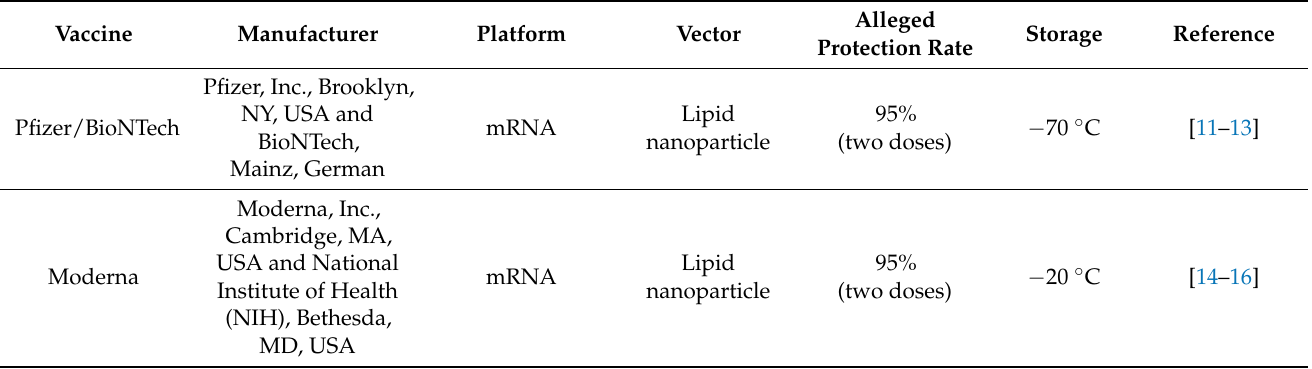
Table 1. Main COVID-19 vaccines approved by the World Health Organization (WHO) or various countries during